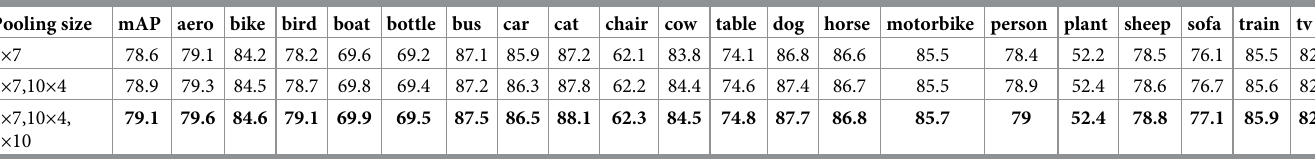
Table 7. Experimental results over the novel enhanced pooling network. Pooling size mAP aero bike bird boat bottle bus car cat chair cow table dog horse motorbike person plant sheep sofa train